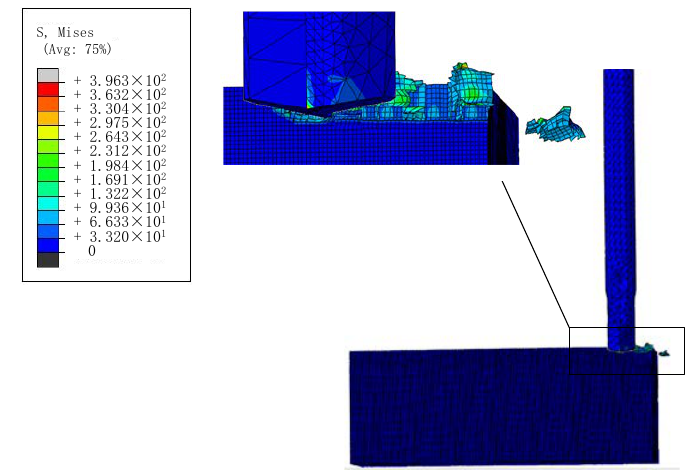
Figure 3. Schematic diagram of simulation results. Table 4. Simulation results of zirconia ceramic milling.